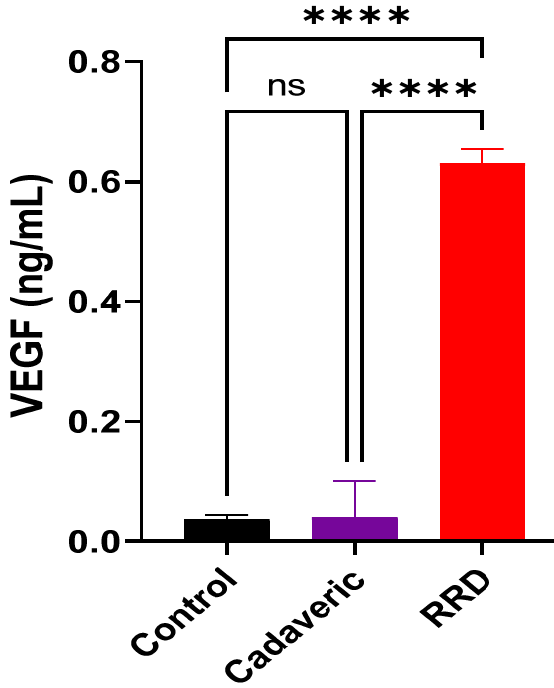
Figure 1. Mean expression level of VEGF (ng/mL) in the vitreous sample collected from the control, cadaveric, and RRD groups. Data shown as mean ± SD were analyzed by one-way ANOVA using Sidak’s multiple comparisons test. * indicates p ≤ 0.05, ** indicates p < 0.01, *** indicates p < 0.001, and **** indicates p < 0.0001; ns represents